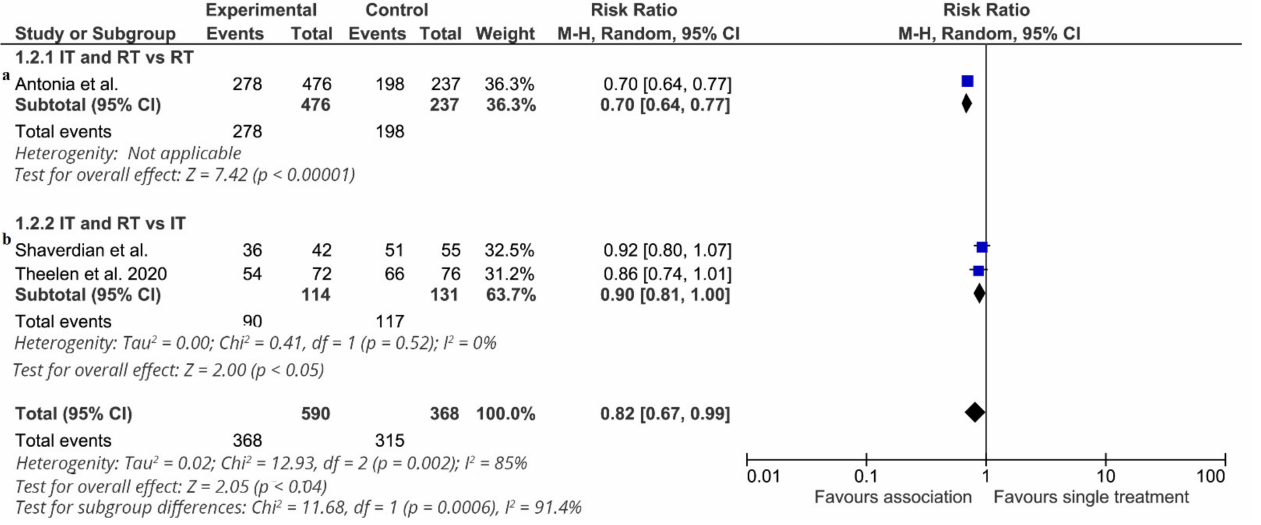
Figure 6. 3-year progression-free survival. Meta-analysis of 3 studies of ICI-RT association: 1 study of ICI-RT vs. RT alone ( a ) and 2 studies of ICI-RT vs. ICI alone ( b ). The risk ratio (RR) and 95% confidence interval (CI) for the effect of treatment on 3-year progression-free survival are shown on a logarithmic scale. Studies are arranged by publication year. Theelen study is a pooled analysis of two